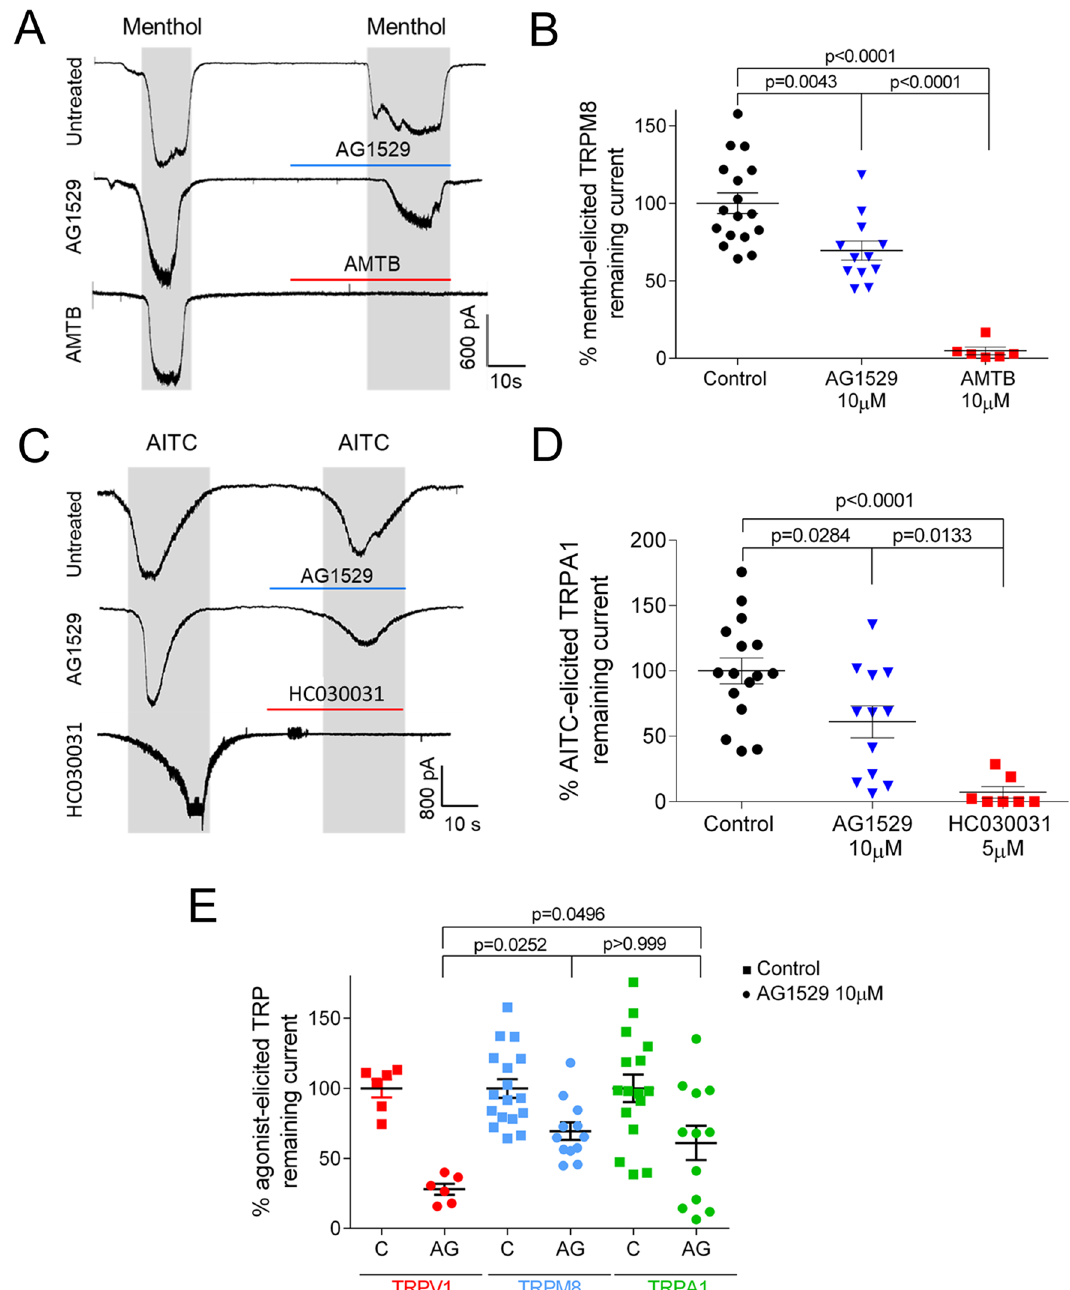
Figure 3. AG1529 marginally inhibits TRPM8 and TRPA1 receptors. ( A ) Representative menthol (100 µM)- elicited hTRPM8 inward currents recorded at a holding potential of − 60 mV, for control cells (Untreated) exposed to two menthol pulses; and, for cells treated with 10 µM AG1529 (AG1529) or 10 µM AMTB (AMTB) for 30 s before the second menthol pulse. ( B ) Percentage of menthol-elicited TRPM8 remaining ionic current with respect to the first menthol pulse. Normalized responses were estimated as (I Menthol2 /I Menthol1 ) × 100. ( C ) Representative AITC (60 µM)-elicited hTRPA1 inward currents recorded at a holding potential of − 60 mV, for control cells (Untreated) exposed to two AITC pulses; and, for cells treated with 10 µM AG1529 (AG1529) or 5 µM HC030031 (HC030031) for 30 s before the second AITC pulse. ( D ) Percentage of TRPA1 ionic current with respect to the first AITC pulse. Normalized responses were estimated as (I AITC2 /I AITC1 ) × 100. Grey rectangles denote the duration of the agonist pulses and horizontal lines the duration of the antagonists pulses. All data are expressed as mean ± SEM. (E ) Comparison of 10 µM AG1529 blockade of hTRPV1, hTRPM8 and hTRPA1. Data were analysed using the One-Way Anova followed by the Bonferroni´s multiple comparison post-hoc test, p-values for statistical differences are indicated. Detail data of the statistical analysis is described in the main